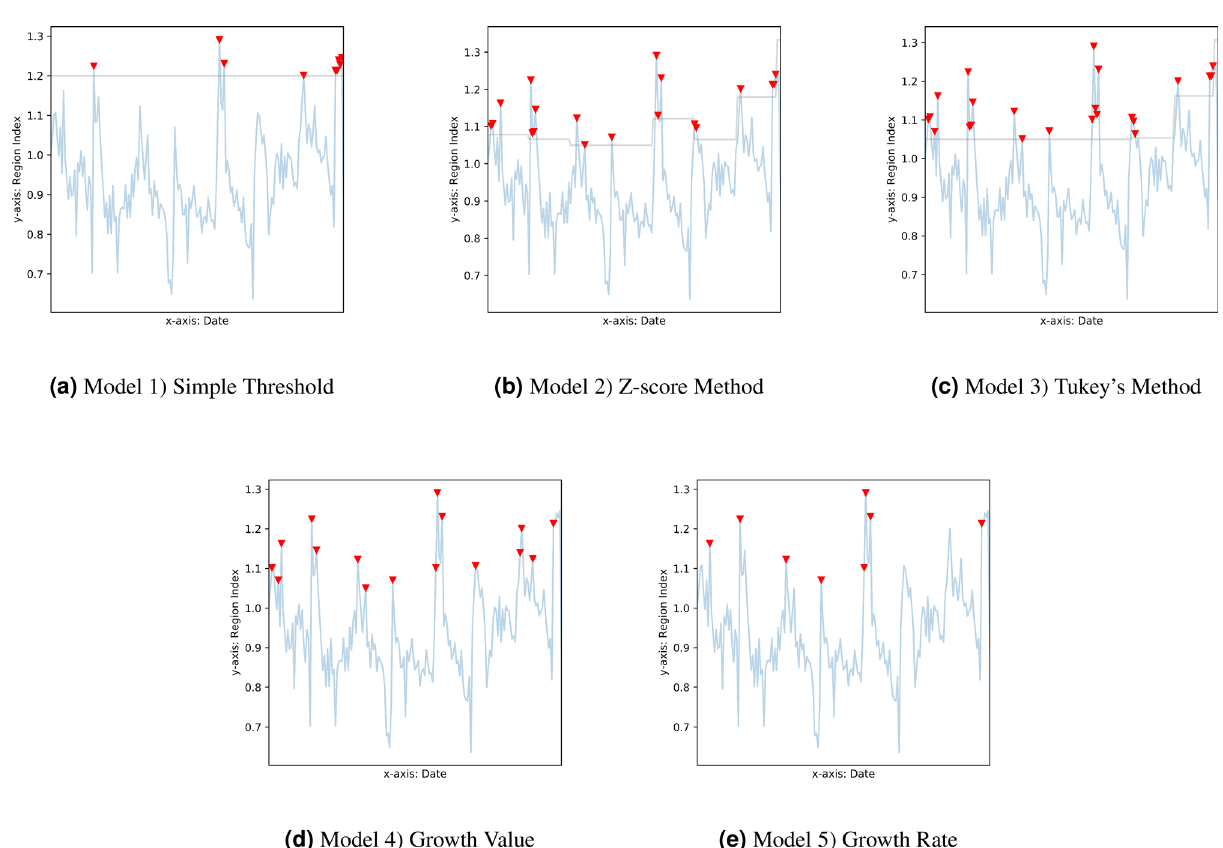
Figure 4. Outlier lables from five Statistics